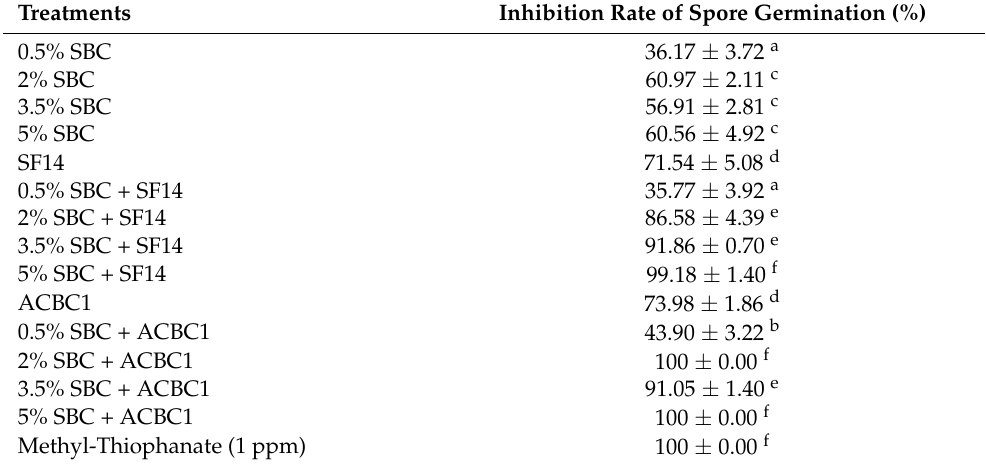
Table 2. Inhibition rate of germination (%) of M. fructigena obtained by sodium bicarbonate (SBC), antagonistic bacteria ( Bacillus amylolquefaciens SF 14 and Alcaligenes faecalis ACBC1), and their combi- nations, after 24 h of incubation at 25 ◦ C in darkness with agitation.